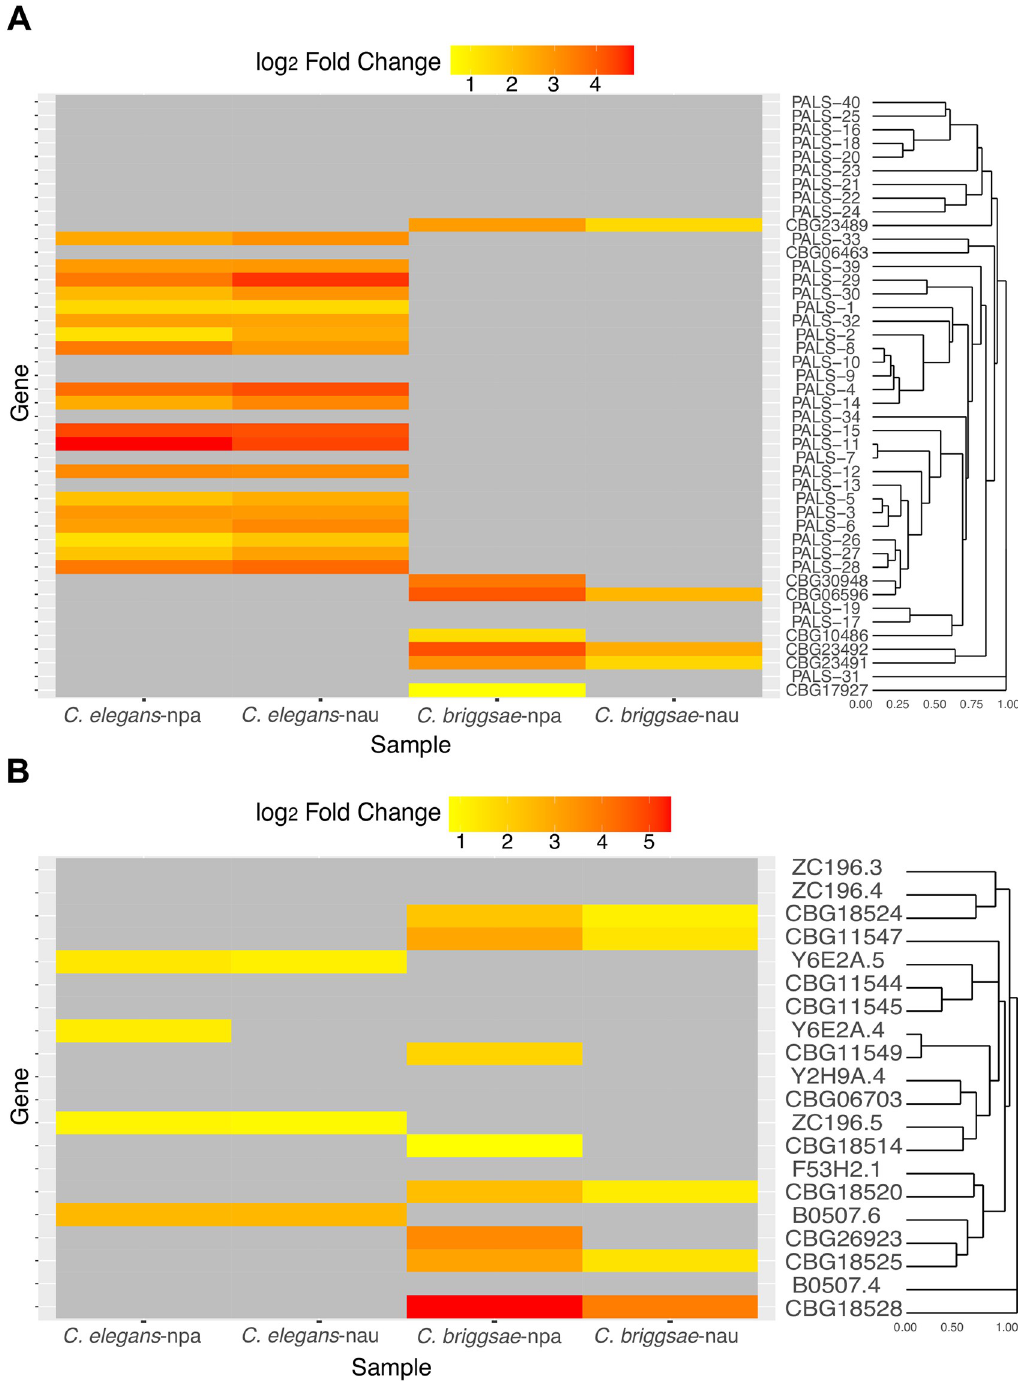
Fig 8. Conserved response of Caenorhabditis hosts to Nematocida infection. (A-B) Heatmap of transcriptional profiles of differentially regulated genes (FDR < 0.05) in the PALS (A) and DUF713 (B) gene families. Scale is of differential regulation of infected compared to uninfected samples. npa ( N . parisii) and nau ( N . ausubeli ).